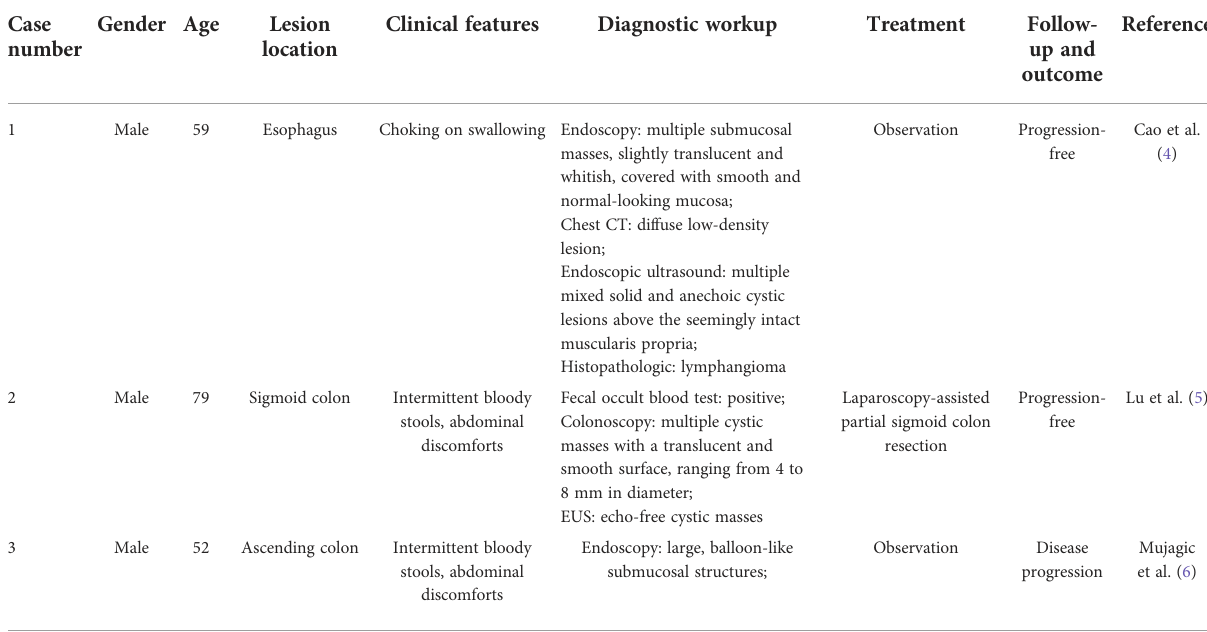
TABLE 1 Previous lymphangiomatosis-related disease